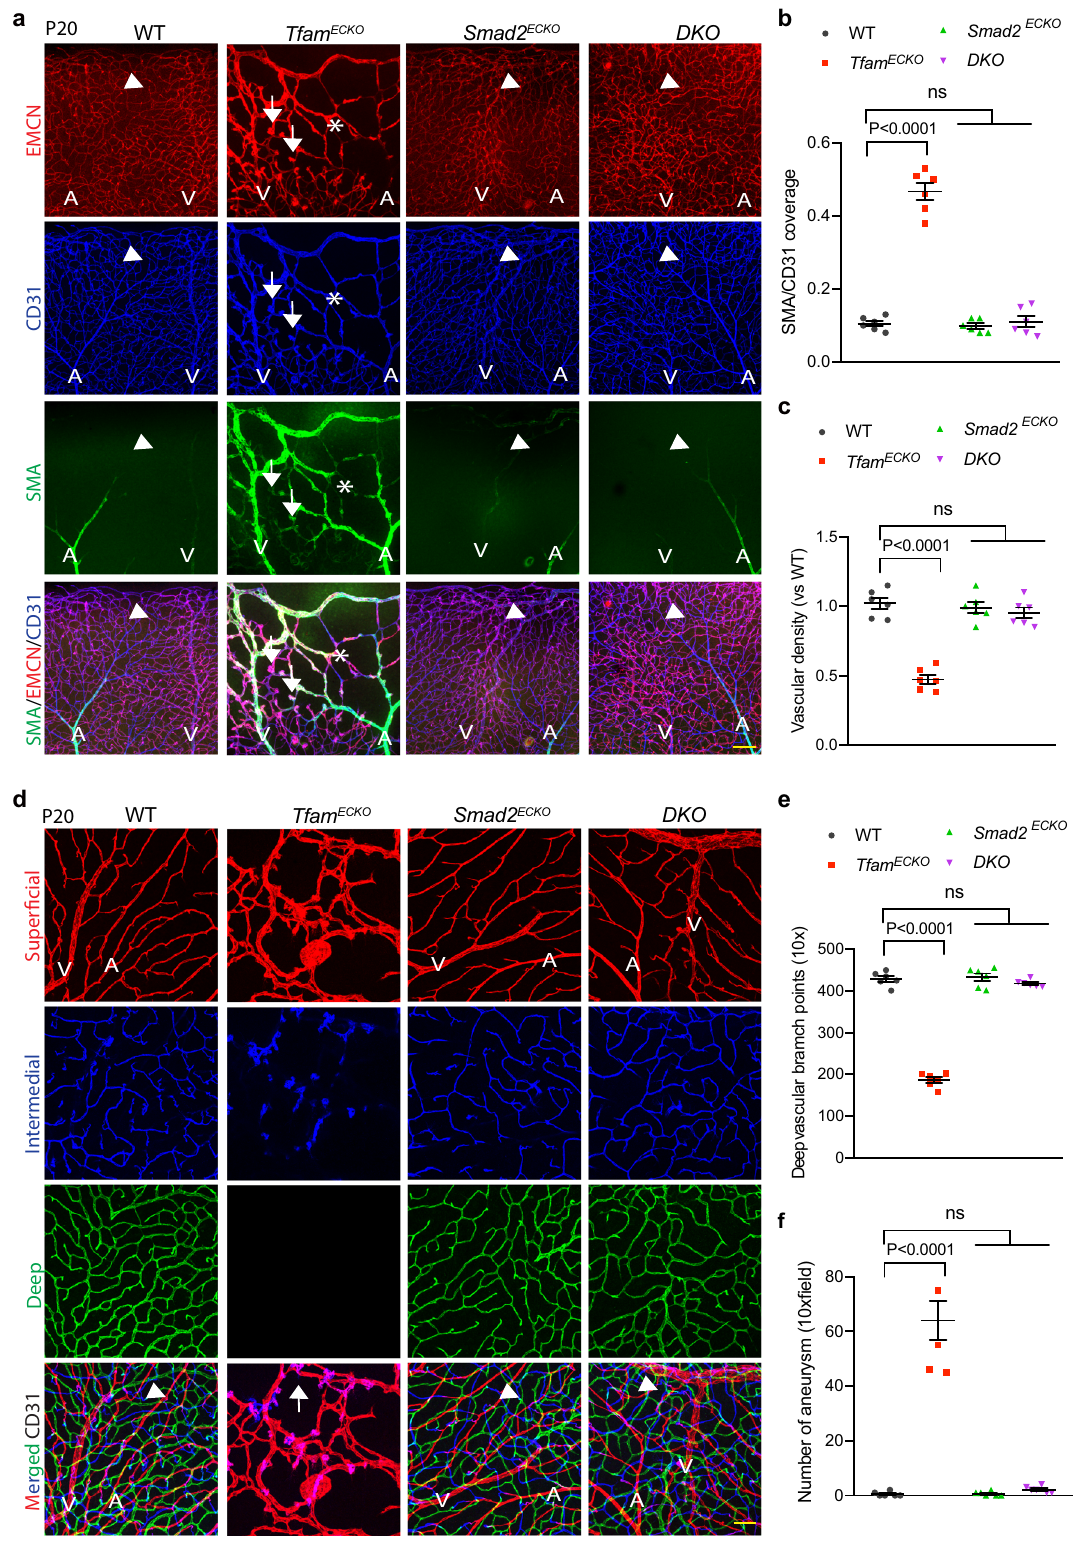
Data processing of scRNA-seq . Alignment, fi ltering, barcode count- ing, and unique molecular identi fi er (UMI) quanti fi cation for deter- mining gene transcript counts per cell (generating a gene-barcode matrix) were performed by the count function of Cell Ranger (v3.0.2; 10x Genomics) with default parameters and the mouse